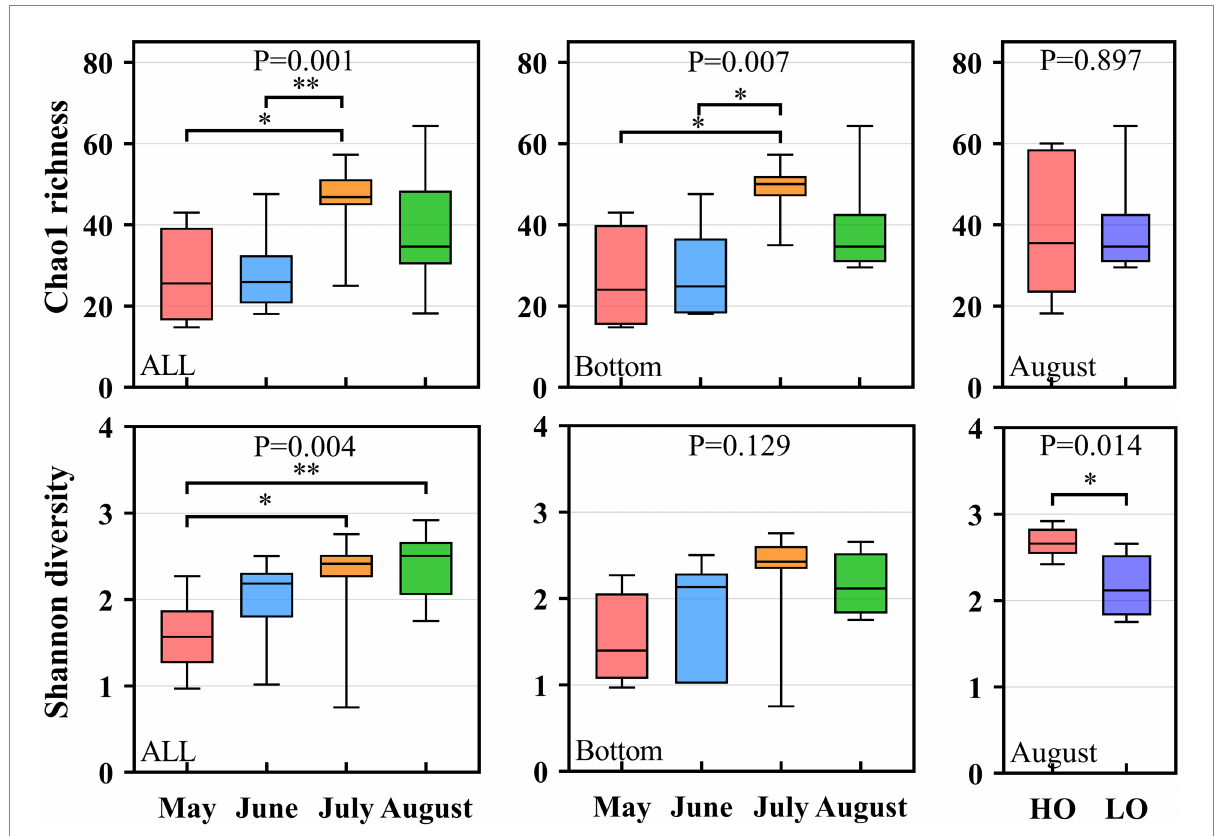
FIGURE 3 Box plots of alpha-diversity (Chao 1 index and Shannon Index) of the pathogenic bacterial communities in different groups in the Bohai Sea. * p < 0.05; ** p <